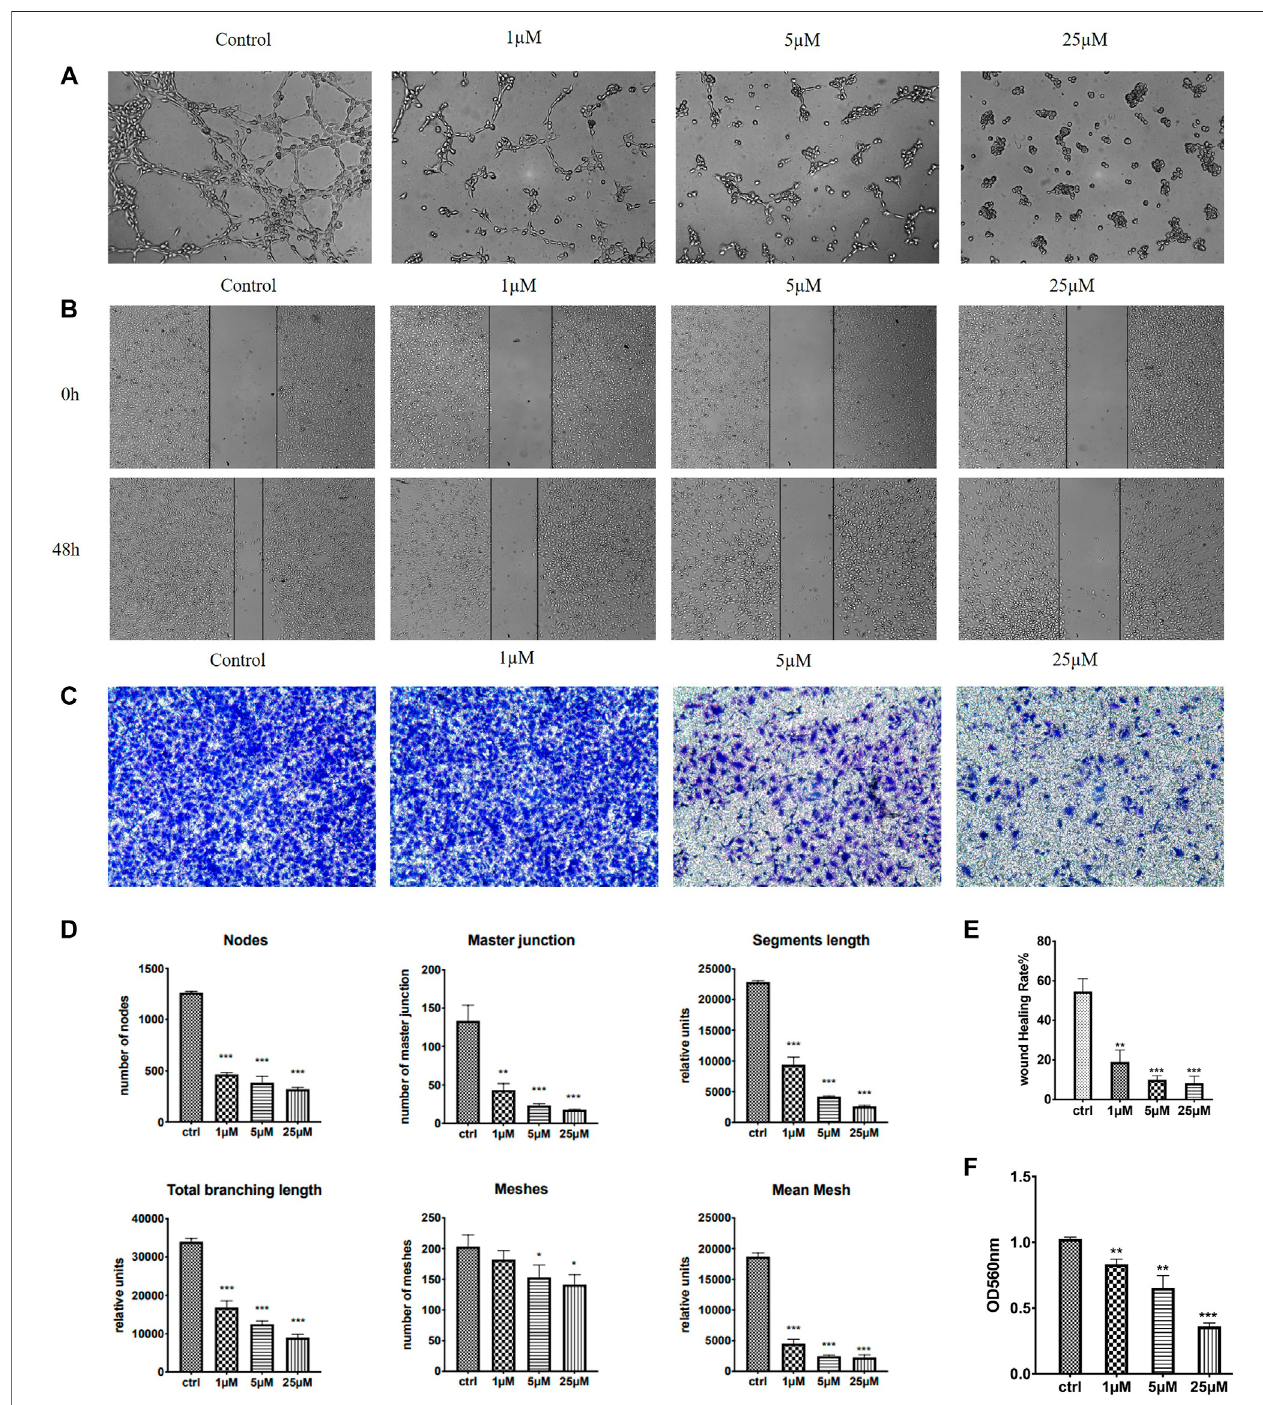
FIGURE 8 | Effect of 7m on the human umbilical vein endothelial cells (HUVECs) migration, invasion, and tube formation. (A) Representative images depicting the vascular structure formationof HUVECs bytreatments with7m for 6 – 8 h. (B) Scratches were created and images were captured using phase-contrast microscopy at 0 and 48 h after treatments with 7m at different concentrations (1, 5, and 25 µM) or 1% DMSO. (C) The invasion suppressing effects of 7m against HUVECs by Transwell assay. (D) Quantitative evaluation of indicated concentrations of 7m on standard parameters of HUVEC tubule formation. Mean ± SEM of three experiments. ** p < 0.01; *** p < 0.001 (E) Inhibitory rates of 7m on the HUVEC migration. (F) Quantitative analysis of the migration ability. * p < 0.05, ** p < 0.01; *** p < 0.001, vs. control; n (cid:1) 3.